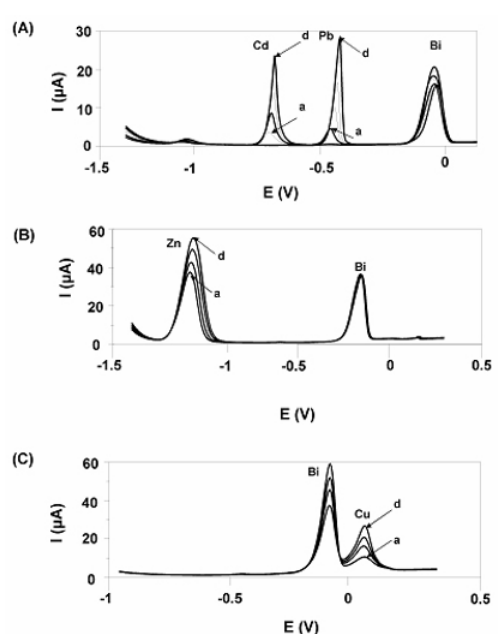
Figure 4. Measurements of (A) Pb( ΙΙ ) and Cd( ΙΙ ), (B) Zn( ΙΙ ) and (C) Cu(II) in mussel tissue ERM-CRM 278. Square- wave stripping voltammograms show a mussel tissue sample (a) and three standard additions (b - d) of 5 μg L -1 of each metal. Preconcentration potential -1.4 V for a preconcentration time of 180 s; “cleaning” for 30 s, at +0.3 V (for the GCE) or at -1.5 V (for the CFE). Other experimental conditions as described in sections 2.5 and 4.1.